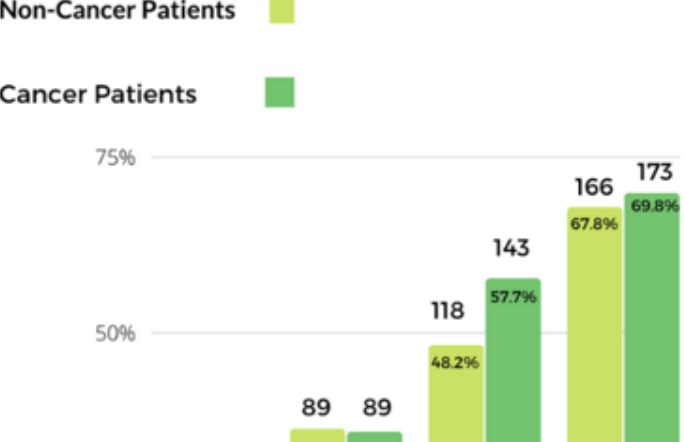
Table 2. Number, prevalence and adjusted odds ratio of COVID-19-related delay in care by socio- demographic factors (n = 493) .